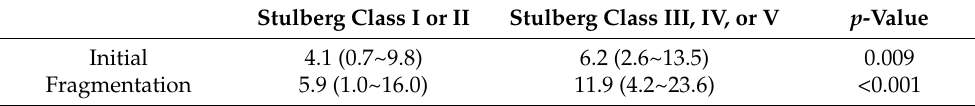
Table 4. Durations of the initial and fragmentation stages in each outcome group.